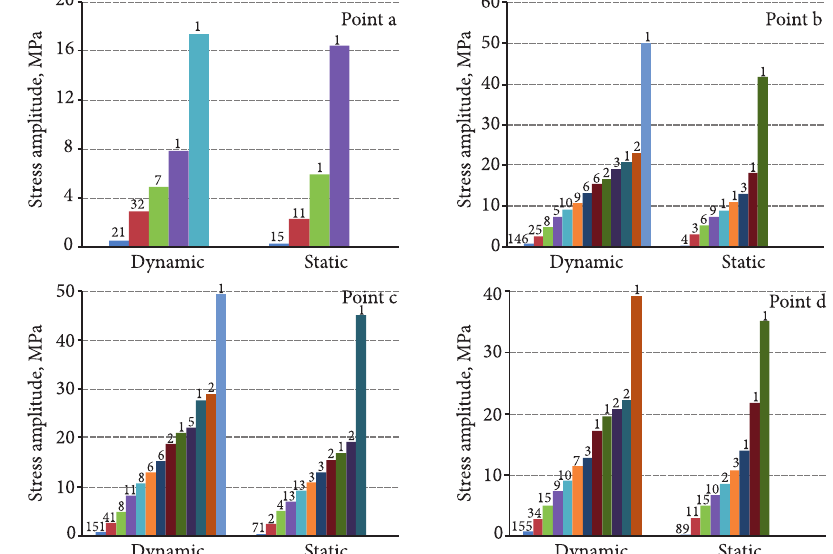
Fig. 9. Discrete stress variation counts at critical points under one train